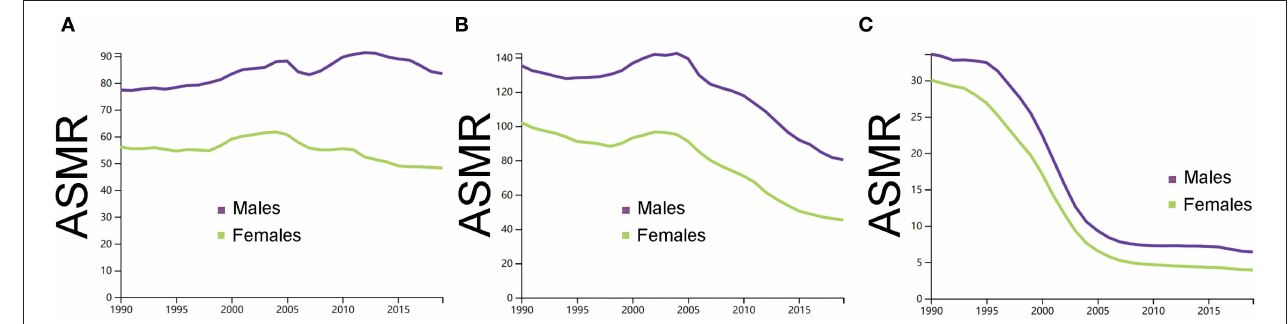
FIGURE 4 | (A) Comparison of men and women in the age-standardized mortality rate per 100,000 of ischemic stroke. (B) Comparison of men and women in the age-standardized mortality rate per 100,000 of intracerebral hemorrhage. (C) Comparison of men and women in the age-standardized mortality rate per 100,000 of subarachnoid hemorrhage. ASMR, age-standardized mortality rate; ICH, intracerebral hemorrhage; and SAH, subarachnoid hemorrhage. The figures were generated through GBD Results